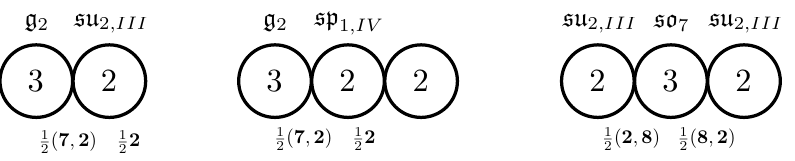
Figure 6 . Gauge algebra and matter content for multiple curve